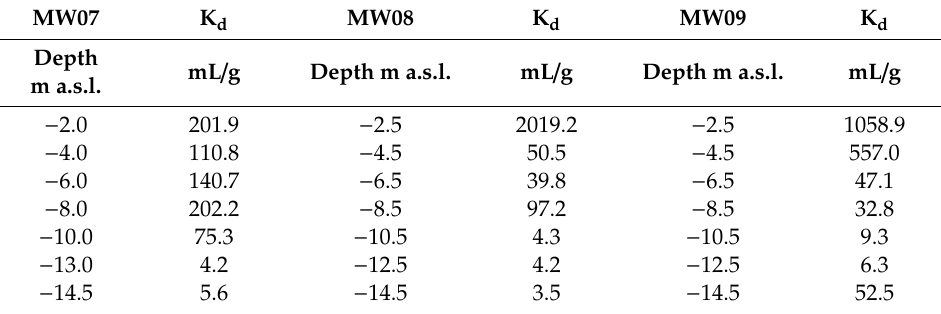
Table 2. Apparent partition coe ffi cient (K d ) calculated for 2018 monitoring